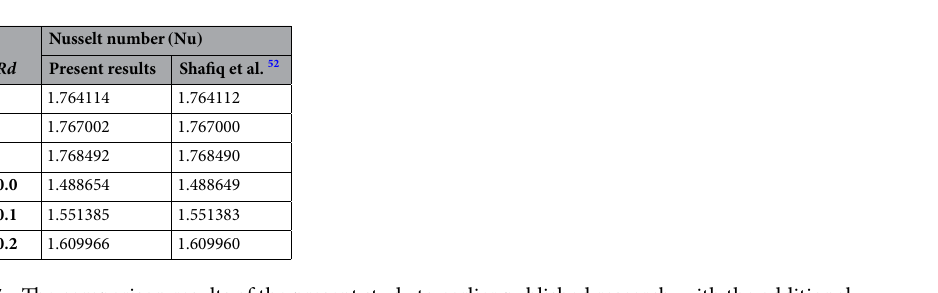
Table 7. The comparison results of the present study to earlier published research, with the additional parameters set to zero. Significant values are in [bold].